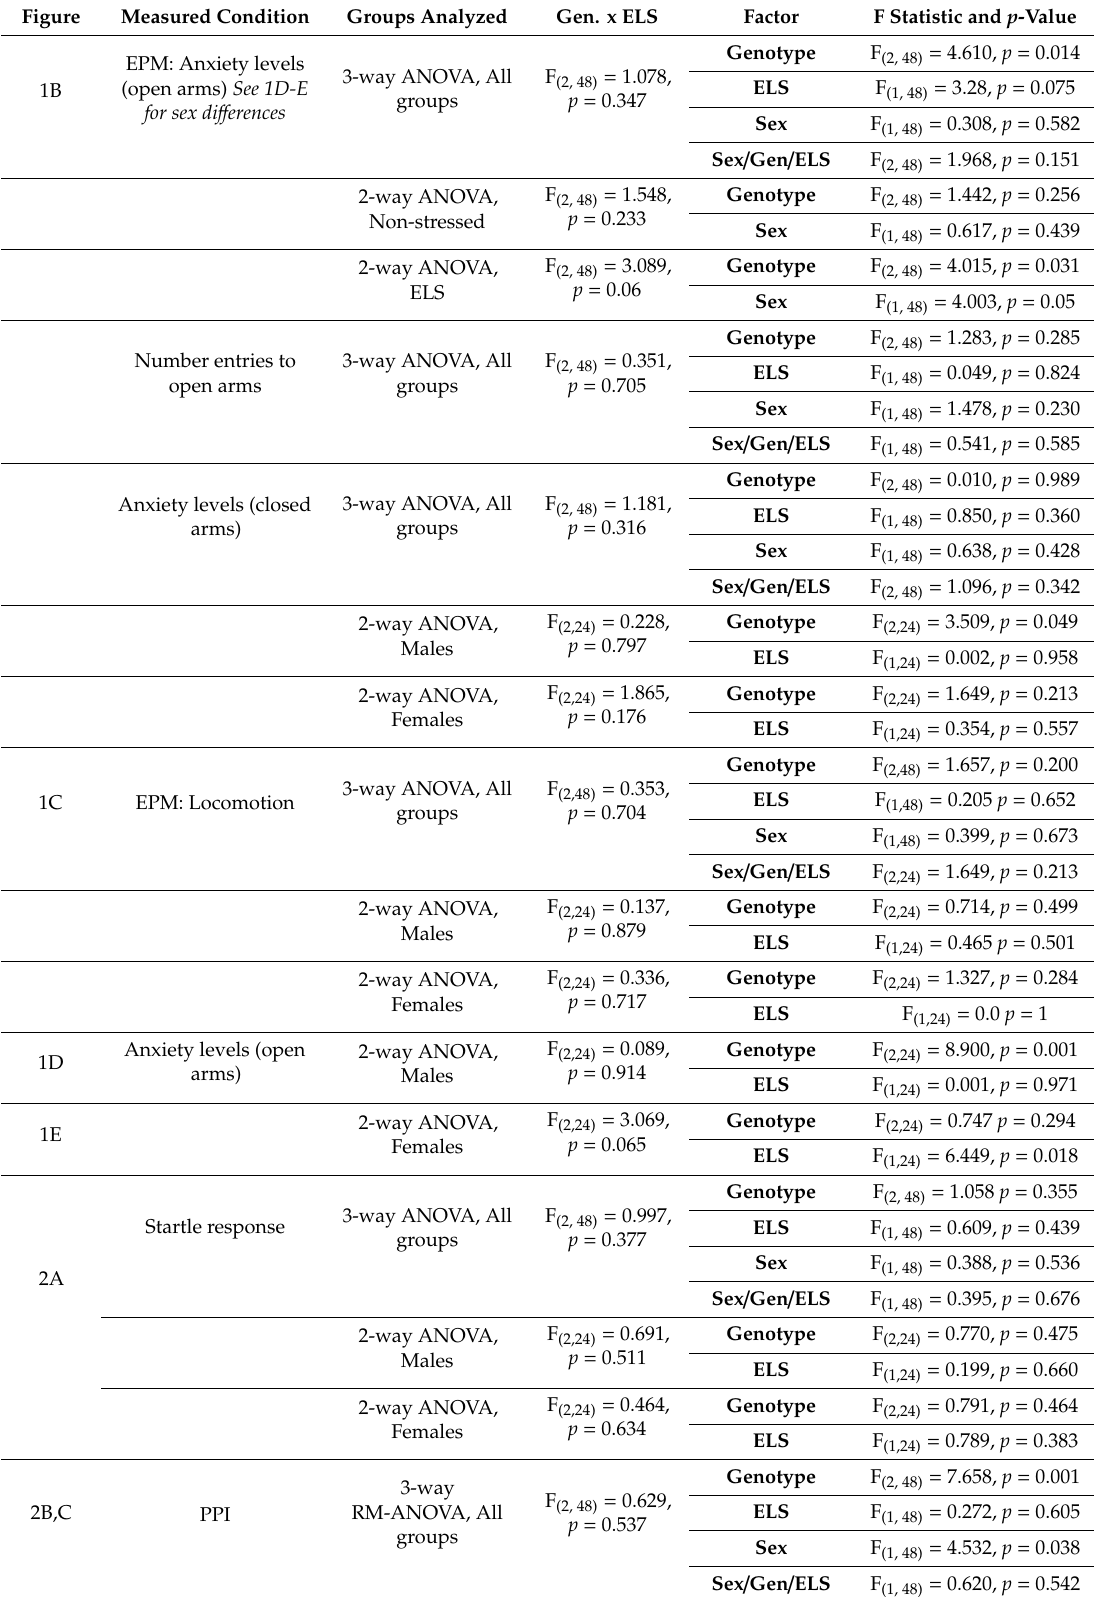
Table 1. Summary of statistical analyses of behavioral tasks.